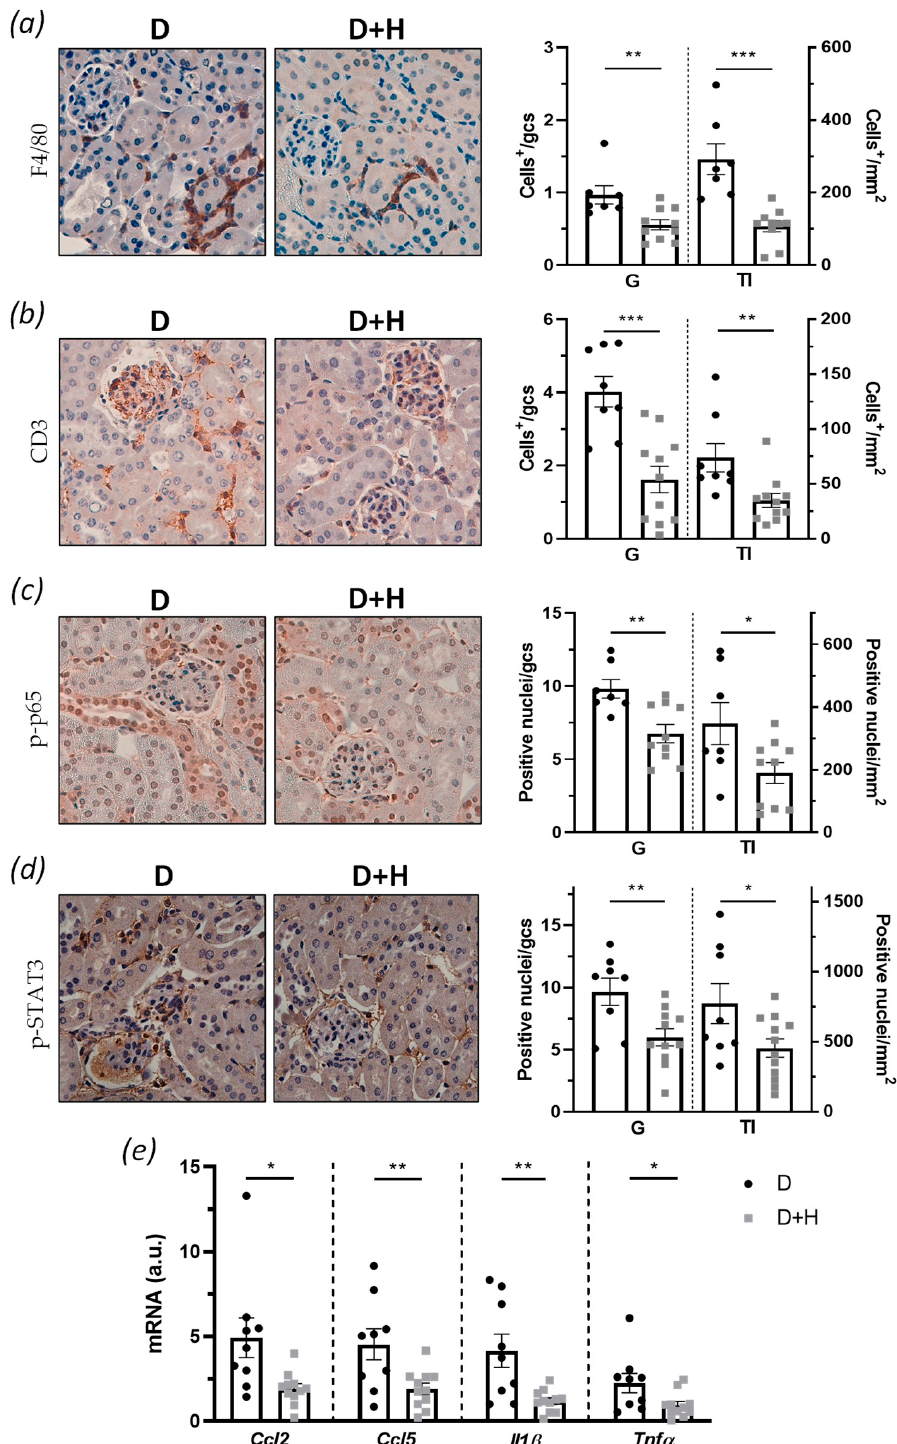
Figure 4. Anti-inflammatory effect of hidrosmin in diabetic kidney: ( a – d ) representative images (original magnification, × 400) and quantification of positive immunostaining for ( a ) CD3, ( b ) F4/80, ( c ) p-p65, and ( d ) p-STAT3 in diabetic groups (control, D; hidrosmin, D + H). Values are expressed as positive cells per glomerular cross section (gcs) in glomeruli (G) or mm 2 in tubulointerstitium (TI); ( e ) real-time PCR analysis of inflammatory genes in renal cortex. Values normalized to 18S are expressed as arbitrary units (a.u.). The graphs represent individual values and mean ± SEM of n = 7–9 animals (D group) and n = 10–11 animals (D + H group). * p < 0.05, ** p < 0.01, and *** p < 0.001 vs.